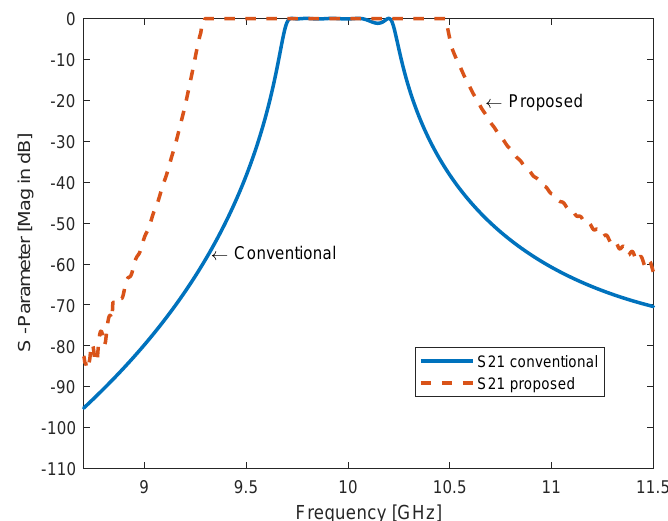
Figure 19. S-parameter comparison between conventional rectangular waveguide filter with direct waveguide junctions and meta-resonator waveguide filter without waveguide junctions for X-band, N = 5. The proposed filter has enhanced the bandwidth to 37.5% as seen in the